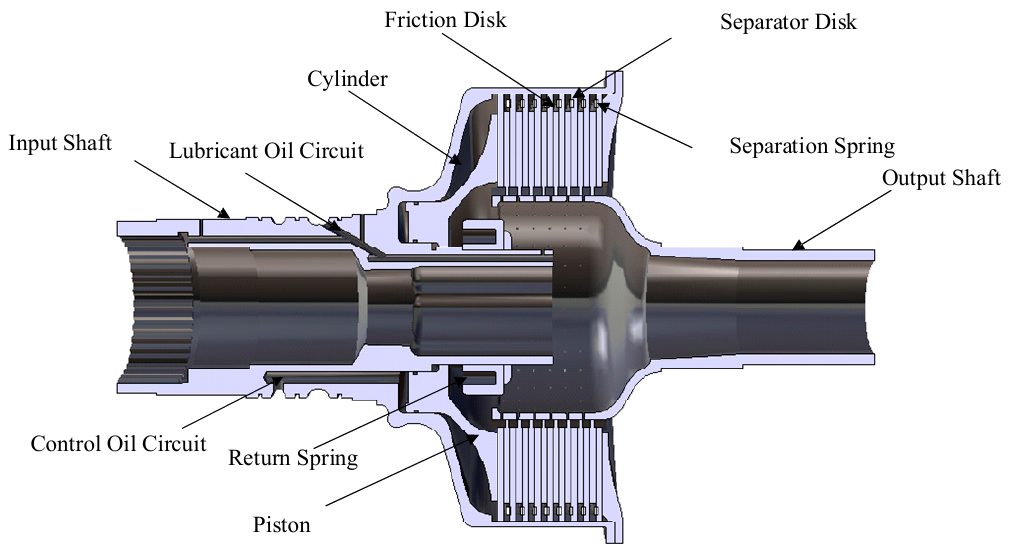
Figure 1. Schematic diagram of a wet multi-disk clutch.